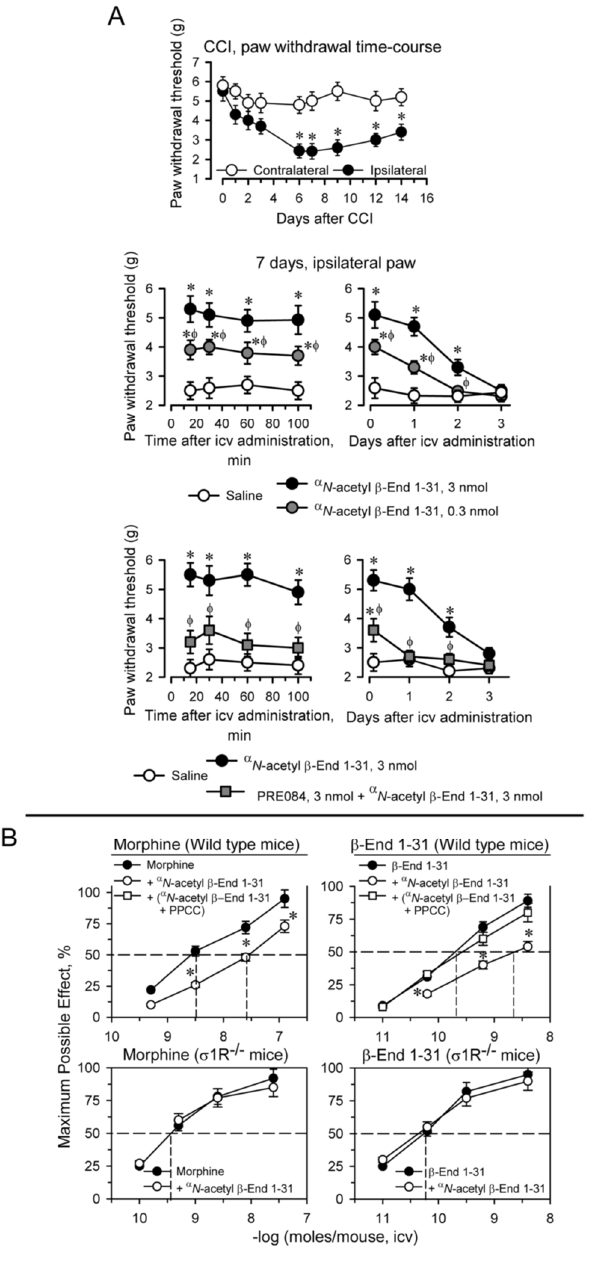
Figure 2. α N -acetyl β -End 1–31 exhibited antiallodynic effects and reduced β -End 1–31 and morphine Figure 2. α N ‐ acetyl β‐ End 1–31 exhibited antiallodynic effects and reduced β‐ End 1–31 and mor ‐ phine analgesia. Implication of σ 1Rs. ( A ) Effect of α N ‐ acetyl β‐ End 1–31 on the mechanical allodynia analgesia. Implication of σ 1Rs. ( A ) Effect of α N -acetyl β -End 1–31 on the mechanical allodynia induced by chronic constriction injury (CCI) of the sciatic nerve. Upper panel: the withdrawal thresholds of the contralateral and ipsilateral paws were measured before (indicated as 0) and up to 14 days after surgery. The force (in grams) at which the mice withdrew their paws in response to von Frey hair stimulation was determined as an index of mechanical allodynia. * Significantly dif ‐ ferent from the value of the contralateral paw. Middle panel: 0.3 and 3 nmol of α N ‐ acetyl β‐ End 1– 31 were administered icv 7 days after surgery, and the nociceptive threshold was evaluated at the indicated postinjection intervals (in minutes). For every time interval studied in min or days, * indi ‐ cates a significant difference from the group that received saline instead of α N ‐ acetyl β‐ End 1–31;  significant difference from the effect of 3 nmol α N ‐ acetyl β‐ End 1–31. Lower panel: the antiallodynic effect of 3 nmol α N ‐ acetyl β‐ End 1–31 was diminished by coadministration of 3 nmol PRE084. * Sig ‐ nificantly different from the group which received saline instead of α N ‐ acetyl β‐ End 1–31.  Signifi ‐ cantly different from the group that received only α N ‐ acetyl β‐ End 1–31. All data are presented as the mean ± SD of six mice. ANOVA followed by the Holm–Sidak multiple comparisons test, p < 0.05, 1 ‐β > 0.80. ( B ) Effect of α N ‐ acetyl β‐ End 1–31 on morphine and β‐ End 1–31 analgesia in mice. Upper